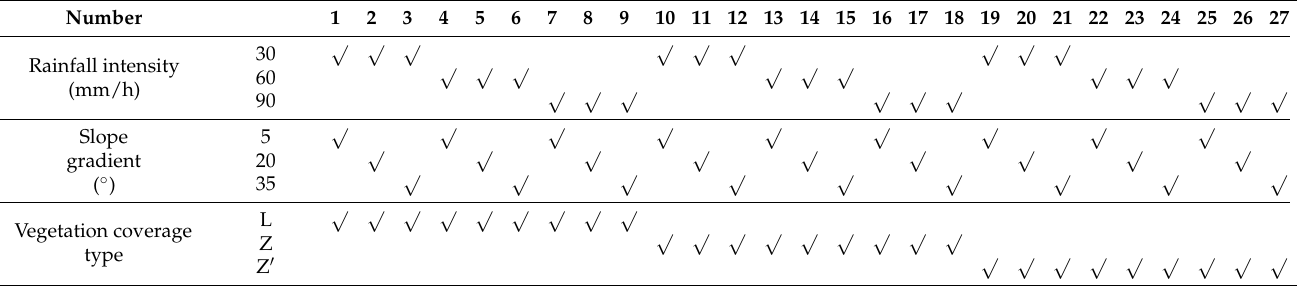
Table 5. Different sequence of combinations (rainfall intensity, slope and vegetation cover